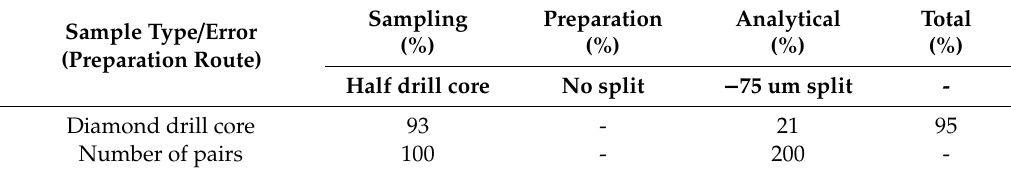
Table 18. Core sample duplicate pair